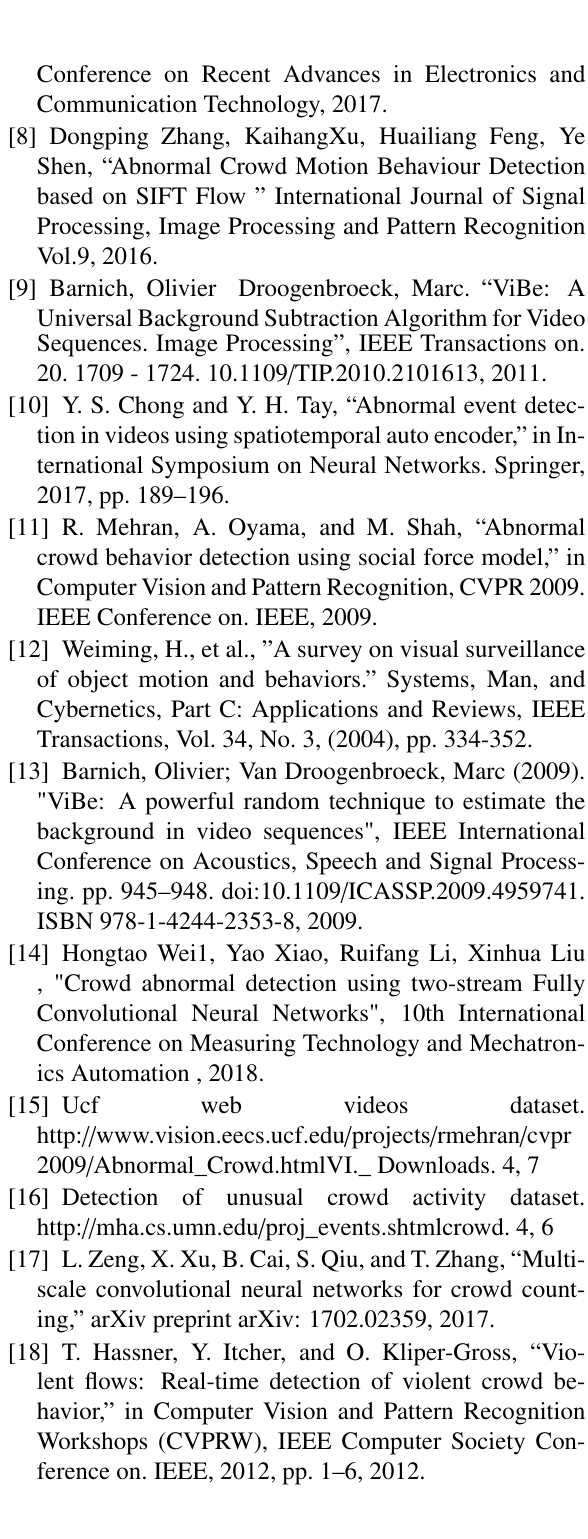
Figure 3. Abnormal activity is detected